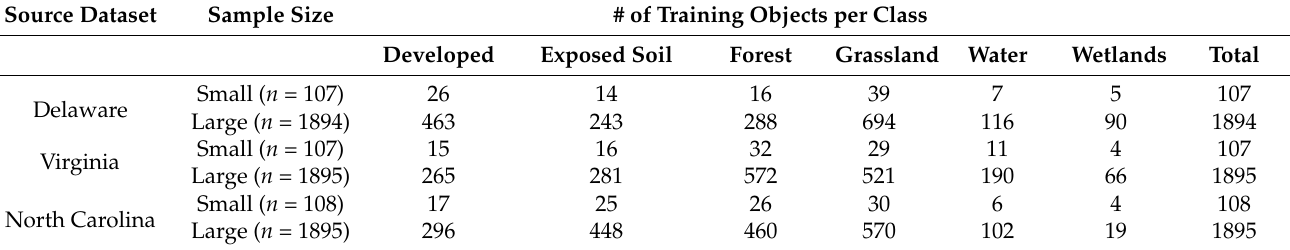
Table 4. Large and small training sets via random sub-sampling. Note that 10 unique training sample sets were created for each series of training